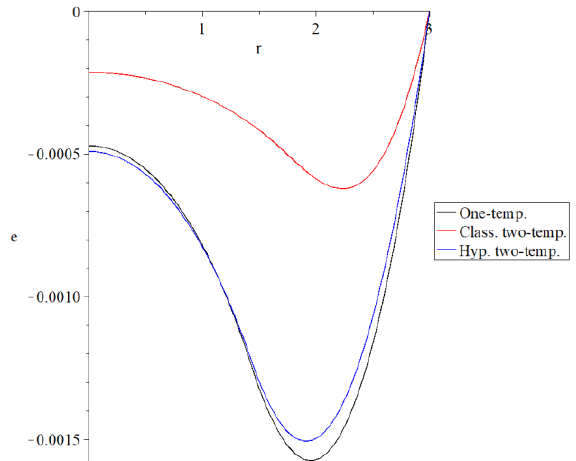
Figure 4. The distribution of the volumetric strain for the variance values of the two-temperature parameter when 0.2 D = .